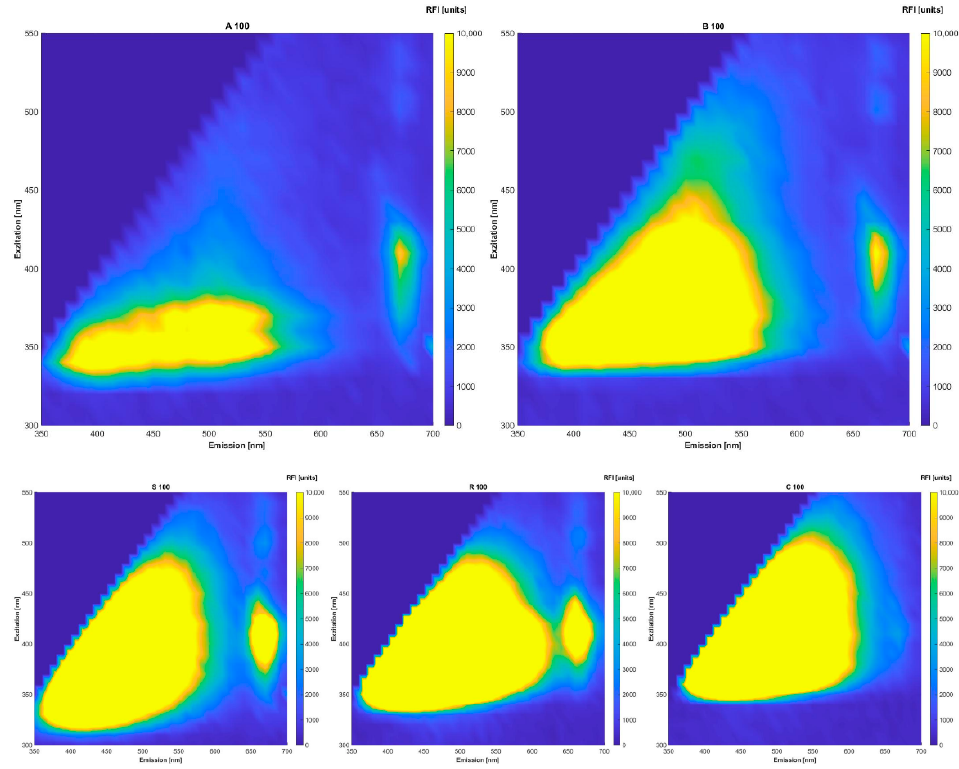
Figure 1. Fluorescence spectra of native oils, A: chia, B: chia, S: sunflower, R: rape seed, C: corn. For NIR and Raman spectra, the native oil spectra are presented in Figures 2 and